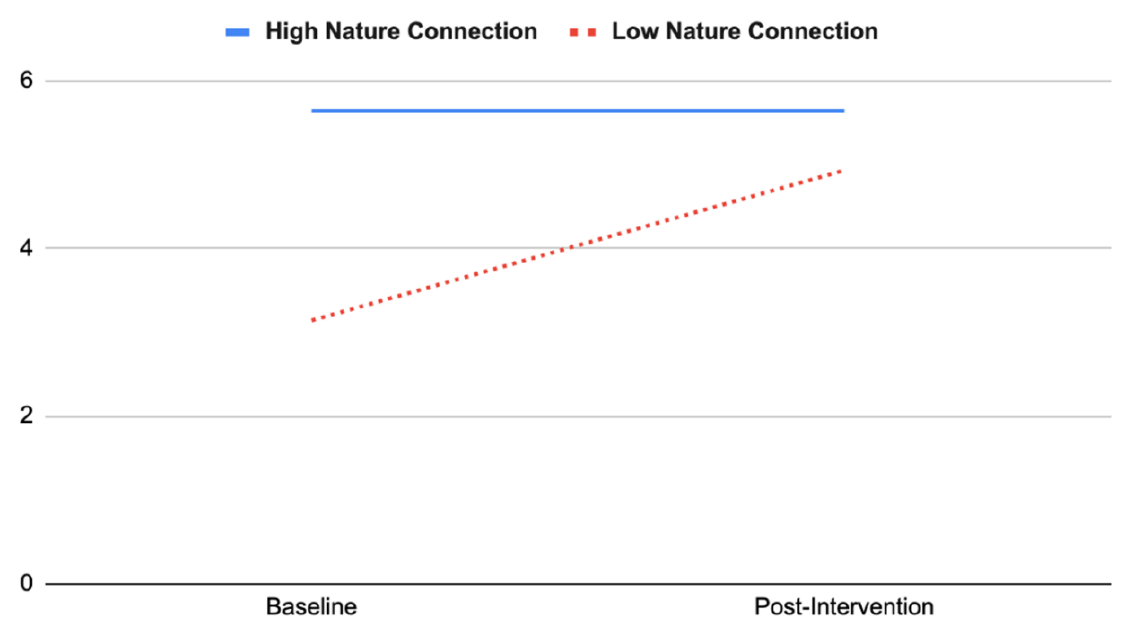
Figure 3. Interaction effect between baseline nature connection and change in nature connection.